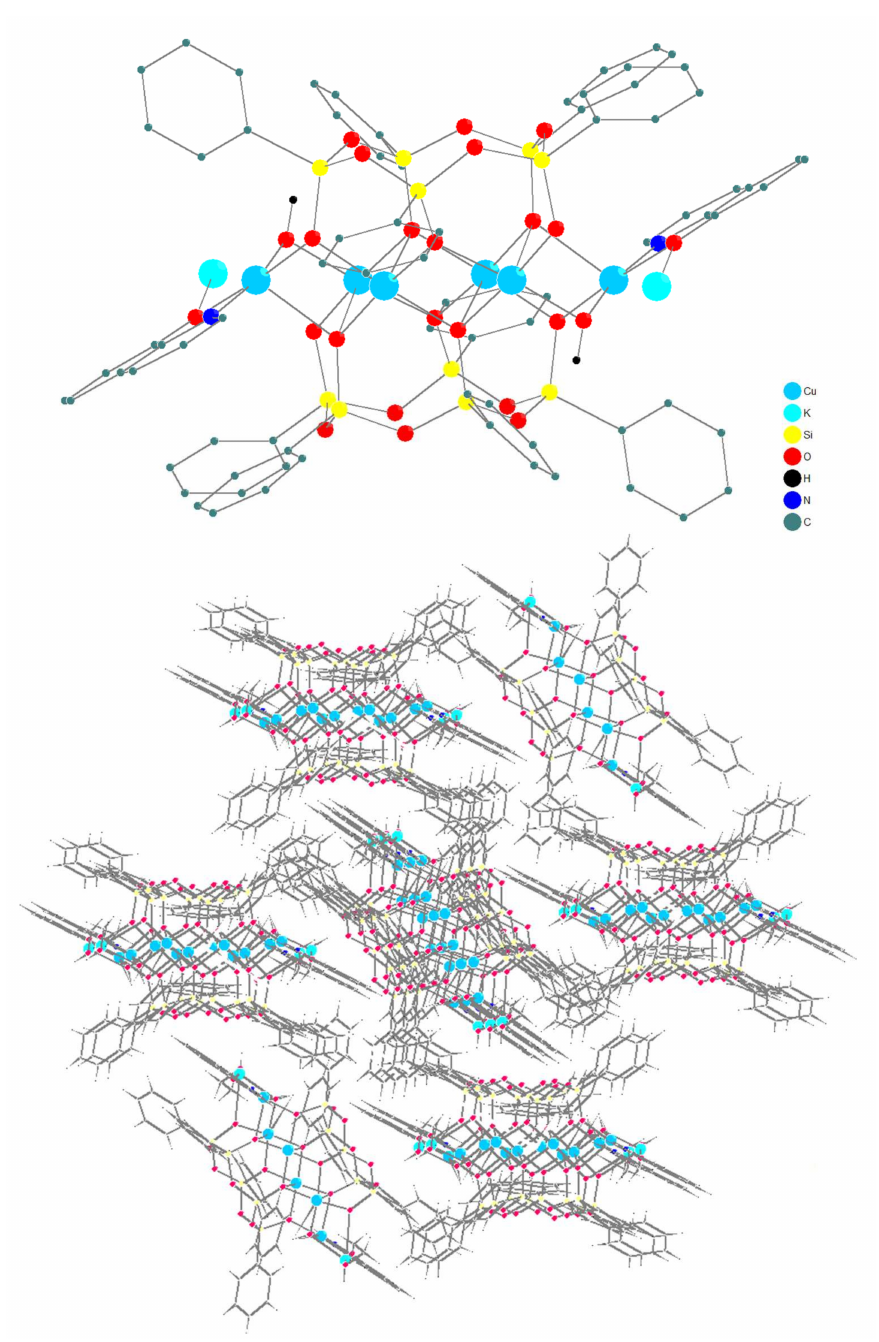
Figure 4. The molecular structure ( top ) and crystal packing ( bottom ) of 5